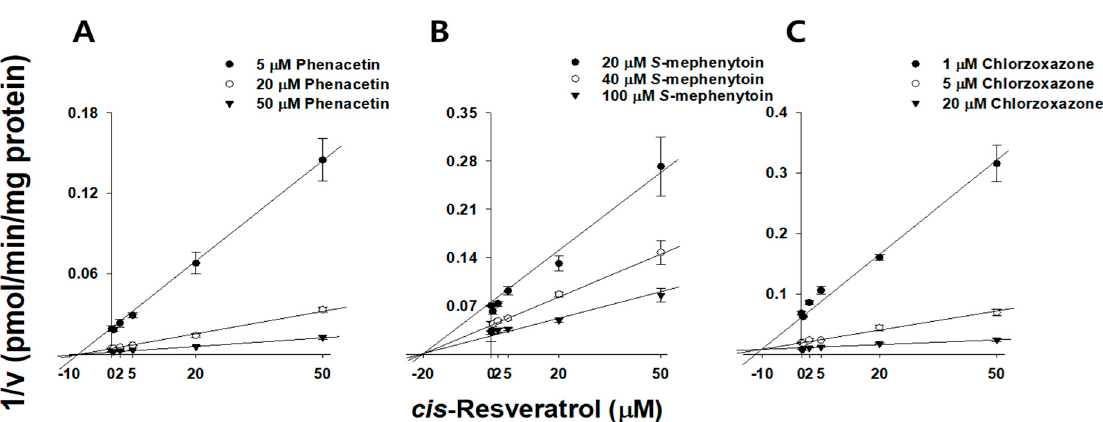
Figure 4. Representative Dixon plots obtained from an inhibition kinetic study of CYP1A2-mediated phenacetin O -deeth- ylation ( A ); CYP2C19-mediated S -mephenytoin 4-hydroxylation ( B ), and CYP2E1-mediated chlorzoxazone 6-hydroxyla- tion ( C ) in the presence of different concentrations of cis -resveratrol in pooled human liver microsomes ( n = 3). Each cis - resveratrol (0, 0.5, 2.0, 5.0, 20, and 50 μ M) was pre-incubated with HLMs in the presence of an NADPH-generating system (30 min, 37 °C), and then an increasing concentration of phenacetin (5 ( ), 20 ( ), and 50 μ M ( )), S -mephenytoin (20 ( ), 40 ( ), and 100 μ M ( )), and chlorzoxazone (1 ( ), 5 ( ), and 20 μ M ( )) added before further incubation for 10 min.